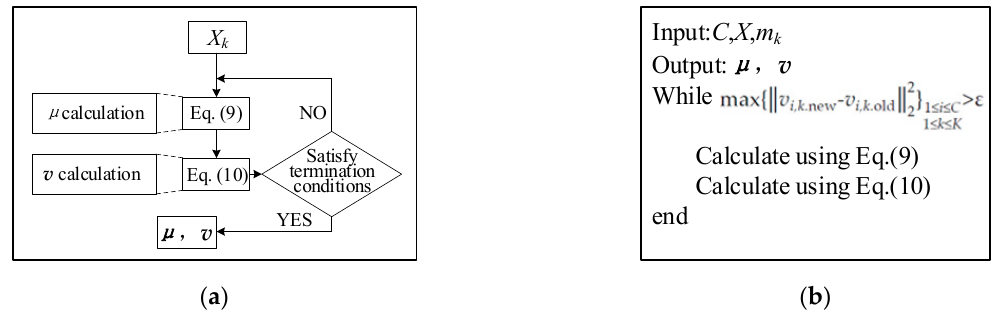
Figure 5. Clustering process of MV-FCM. ( a ) Flow chart, and ( b ) pseudocode.